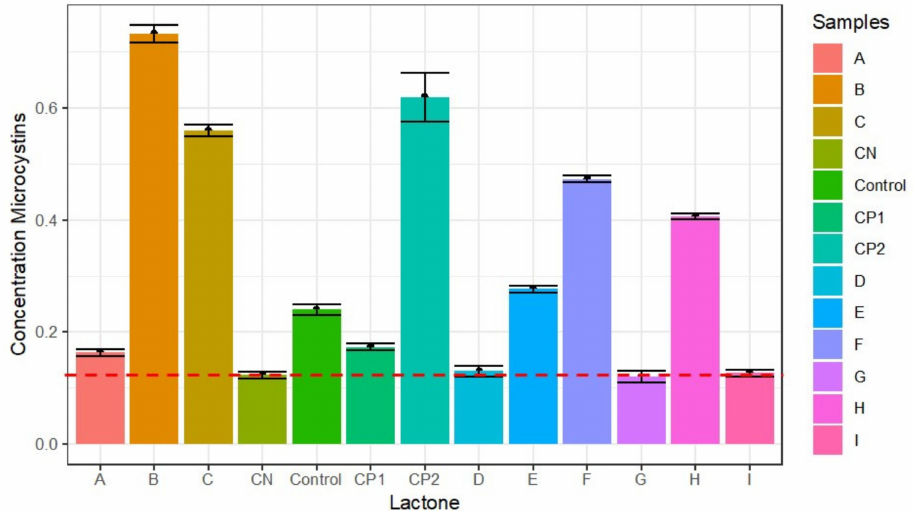
Figure 7. Effects of nine lactones on the production of microcystins in M. aeruginosa , detected by ELISA. CP1 and CP2 are the controls with 0.2 and 0.6 ppb of microcystins, N-(3-oxodecanoyl) ( A ), N-(3-oxododecanoyl ( B ), N-hexanoyl ( C ), N-decanoyl ( D ), N-heptanoyl ( E ), N-dodecanoyl ( F ), N- octanoyl ( G ), N-(3-oxooctanoyl ( H ), N-butyryl-homoserine lactone ( I ). CN: kit calibrator, without microcystins. Lactones B and C were potent inducers of microcystins, but lactones F and H were also good inducers. The others were inactive. The detection of microcystins in control could be caused by a false positive since the reagent detects microcystins LA, RR, and YR.